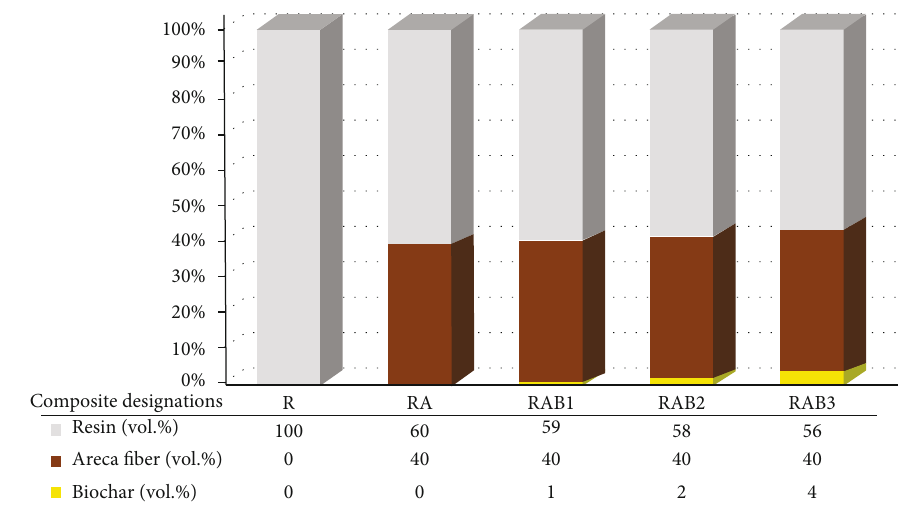
Figure 4: Material compositions for di ff erent composites.